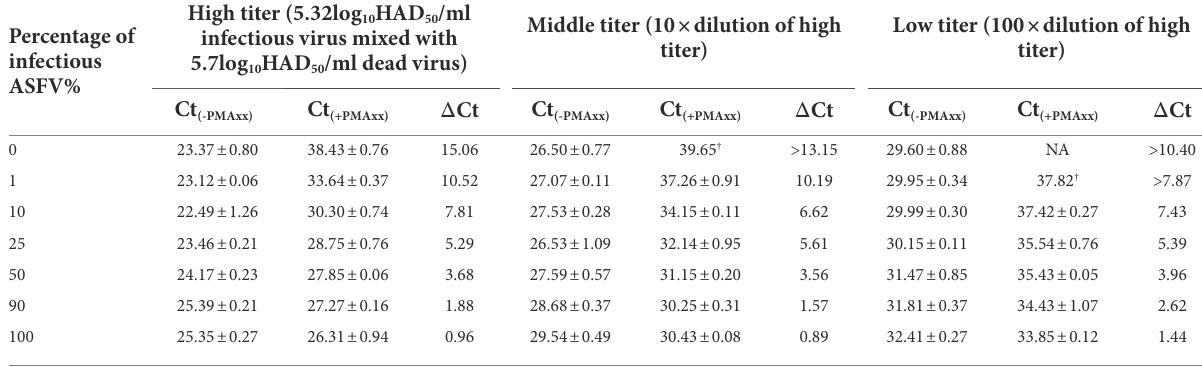
TABLE 3 Determining Δ Ct values from mixtures of infectious and inactivated ASFV under different titers using qPCR (Ct (-PMAxx) ) and Triton X-100 assisted PMAxx-qPCR (Ct (+PMAxx) ) assays. A decrease in Δ Ct values positively correlated to an increase in the percentage of infectious virions across all titers tested. The assay could detect as low as 1% infectious virion in the samples tested with a significantly lower Δ Ct value compared to 100% inactivated ASFV (i.e., 0% infectious ASFV).